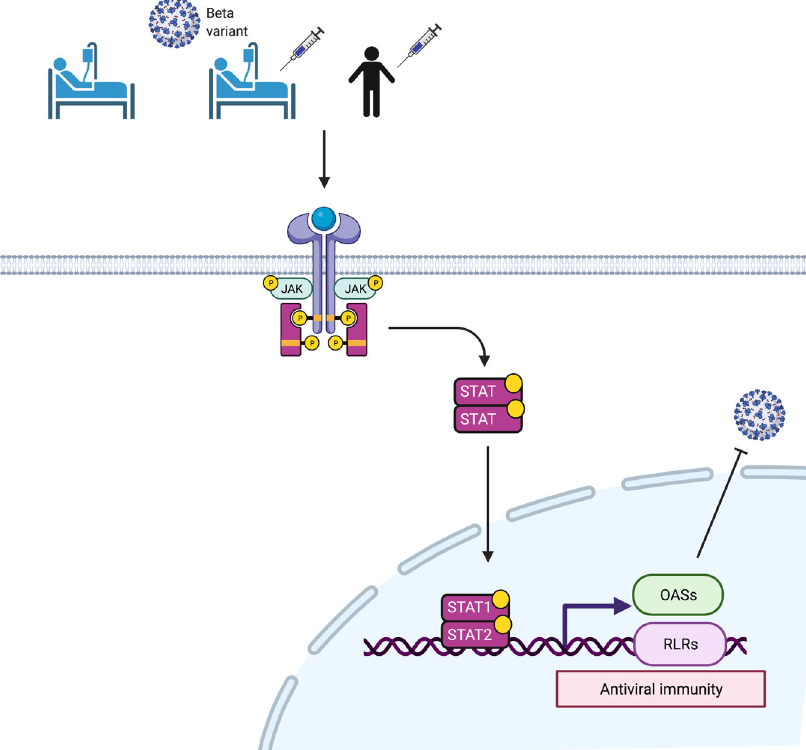
Fig. 6 Illustration of JAK-STAT-dependent antiviral immunity by vaccination. BNT162b2 vaccination activates the JAK-STAT pathway and active STAT transcription factors induce the expression of OAS s and RIG-I-like receptors (RLR) family members related to antiviral response. This fi gure was created with BioRender.com (Agreement number: